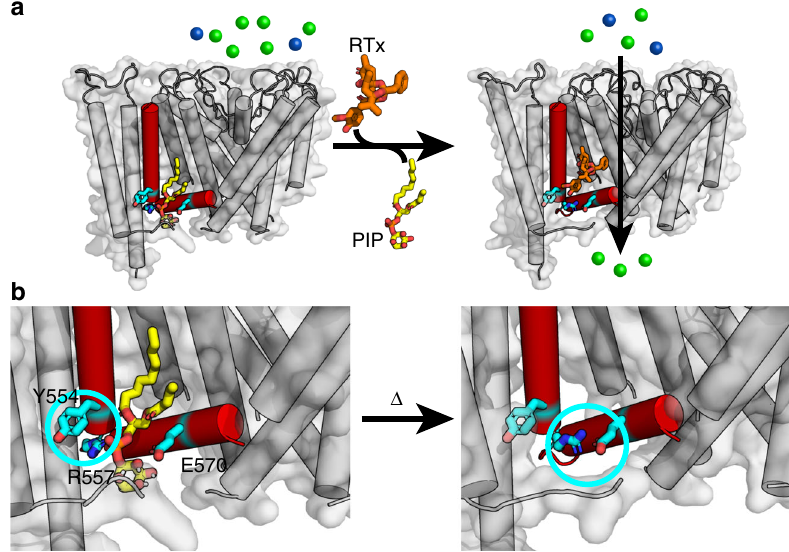
Fig. 6 A proposed heat-sensing mechanism of TRPV1 involves the interaction between the S4 helix and the S4-S5 linker. a Structure-based ligand- gated mechanism of TRPV1 is shown in cartoon (PDB ID: 5IRZ and 5IRX). In the resting state, an endogenous lipid (yellow) occludes the canonical vanilloid binding pocket, perturbing the interaction between the R557 in S4 and E570 in S4 – S5 linker. As a vanilloid ligand, resiniferatoxin (RTx, orange), binds the S1 – S4 domain, the cation – π interaction between R557 and Y554 is disrupted and R557 changes conformation to interact with E570, opening the lower gate. For visual clarity, S3 helix is omitted, and only one S1 – S4 domain is shown. b The close-up views that show the interaction between Y554 and R557 in S4 helix in the resting state (left, highlighted in cyan circle), and the interaction between R557 and E570 in S4-S5 linker (right, shown in cyan circle). Our data suggest that the C-terminal end of the S4 helix undergoes heat-induced movements in this region and loses helicity. This model is analogous to the ligand activation mechanism and suggests an understanding for overlap between heat and ligand